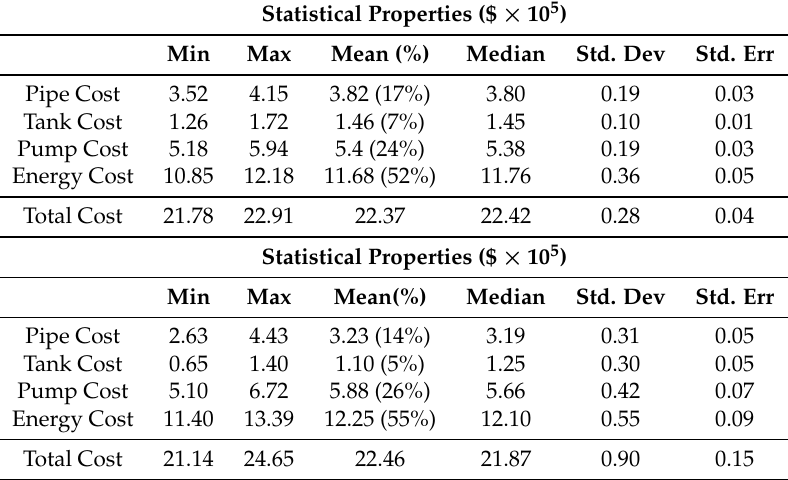
Table 3. Detailed statistics of the cost of each component of the 50 runs with different initial guesses of the flows in the chord tree pipes of the proposed two-stage method and NLP method applied to the two-loop network with four loading conditions (base run). ( a ) The proposed two-stage method. ( b ) The original NLP